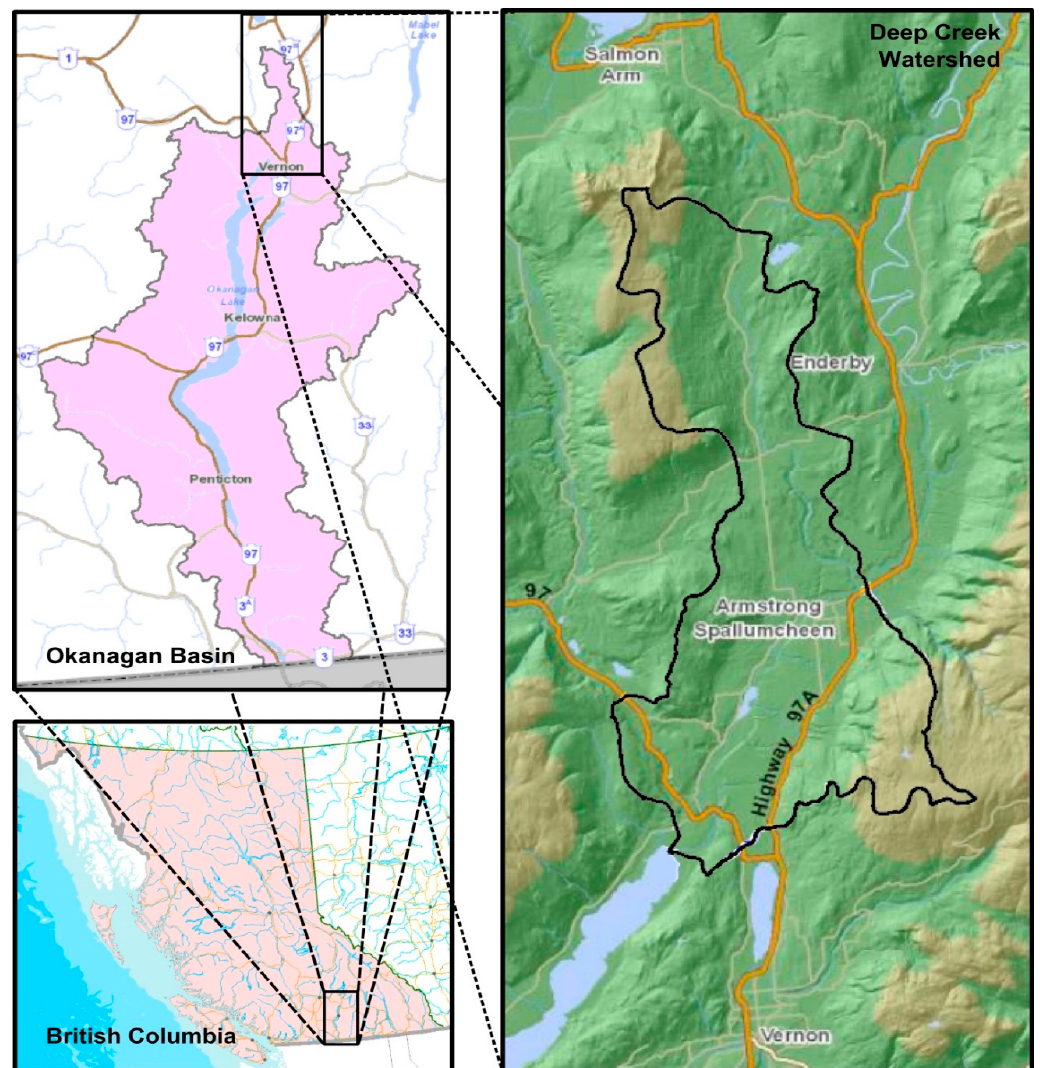
Figure 1. Location of Deep Creek watershed in Okanagan basin of British Columbia, Canada.